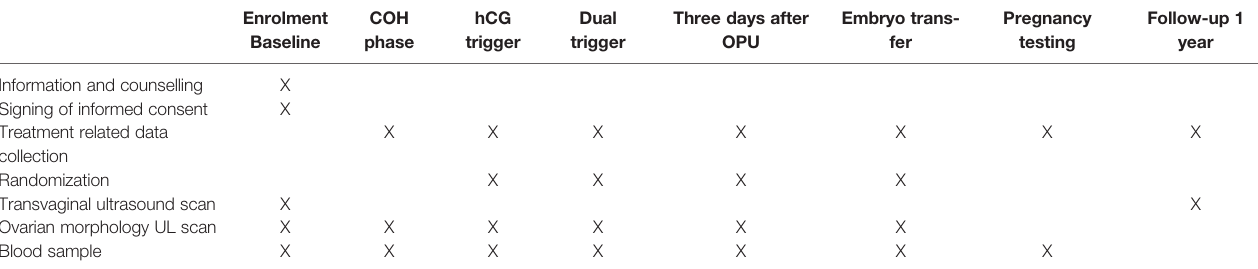
TABLE 1 | Overview of study visits.